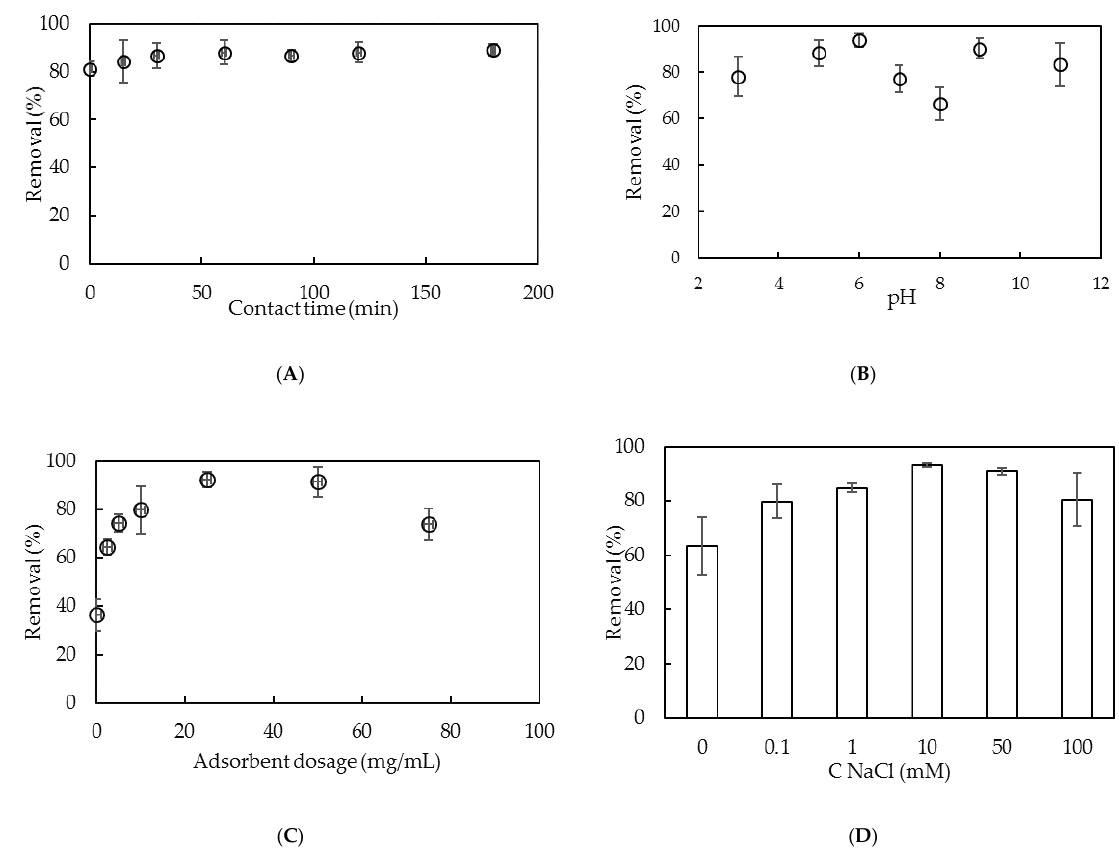
Figure 9. The effects of contact time ( A ), pH ( B ), adsorbent dosage ( C ) and ionic strength ( D ) on lindane removal using surfactant-modified nano-aluminum hydroxide (SMNAH) ( C i (lindane) = 200 µg/L. Error bars indicate the standard deviations of three replicates.